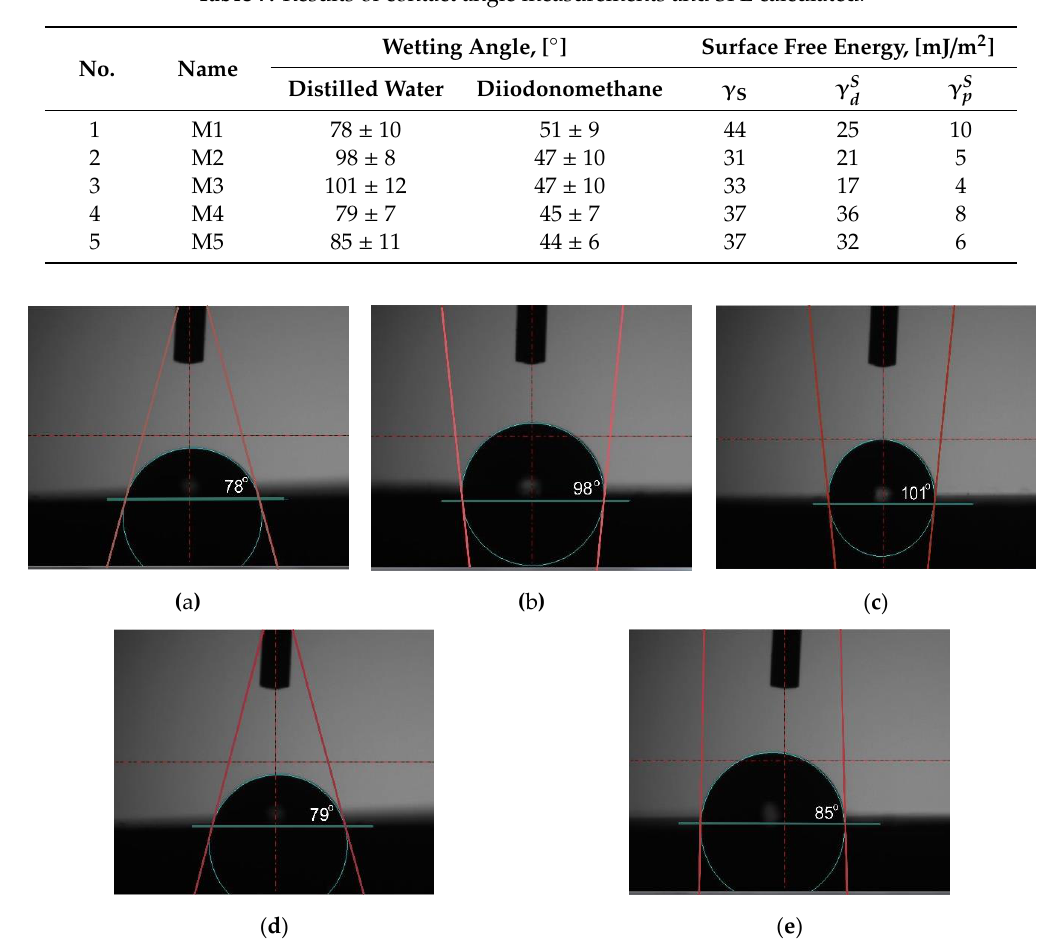
Figure 7. Sample measurement of wetting angle ( a ) M1; ( b ) M2; ( c ) M3; ( d ) M4; ( e ) M5. Table 7. Results of contact angle measurements and SFE calculated.